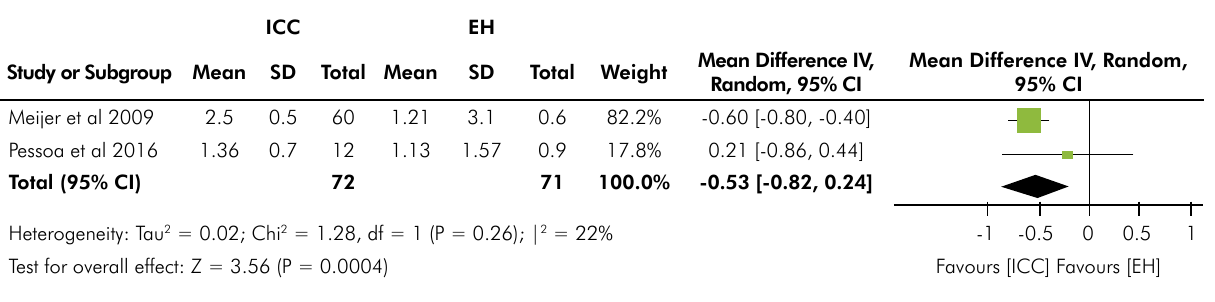
Figure 9. Probing depth after 1